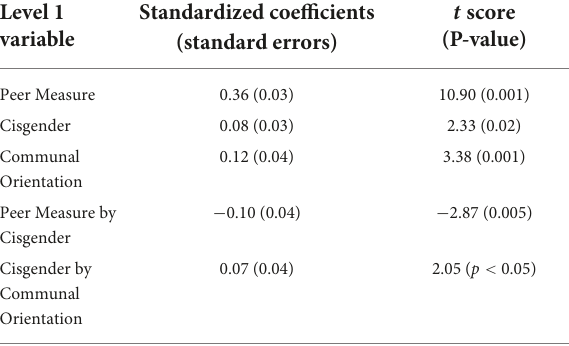
TABLE 2 Person-related predictors of the self-perceived cognitive competence